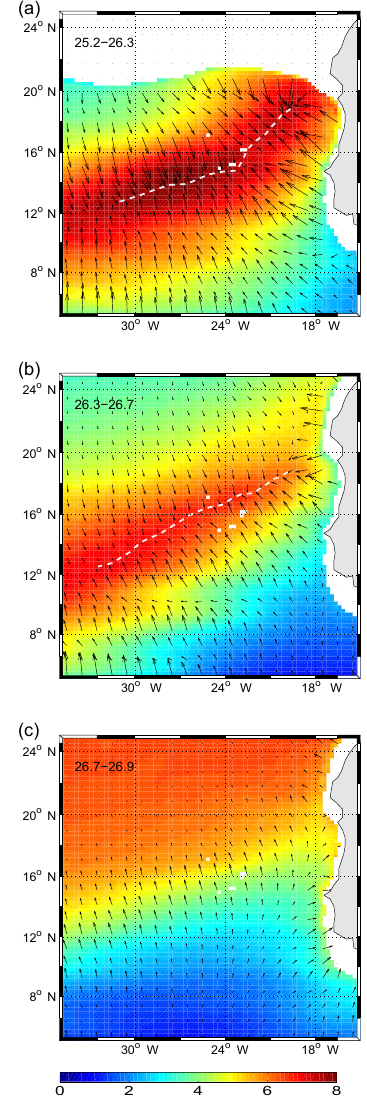
Figure 17. Shallow-water potential vorticity field in the ETNA computed from TROP025 (color; 10 − 8 m − 1 s − 1 ) using Eq. (4) for the density classes 25.2–26.3 (a) , 26.3–26.7 (b) , and 26.7–26.9 (c) . These values are such that the three layers are of comparable thick- ness and the same color scale can be used. Potential vorticity gradi- ents are also shown in vectors. Note the vanishing gradients found along the white dashed lines in panels (a) and (b) (the position of the two lines differ slightly, e.g., see their position with respect to the Cape Verde